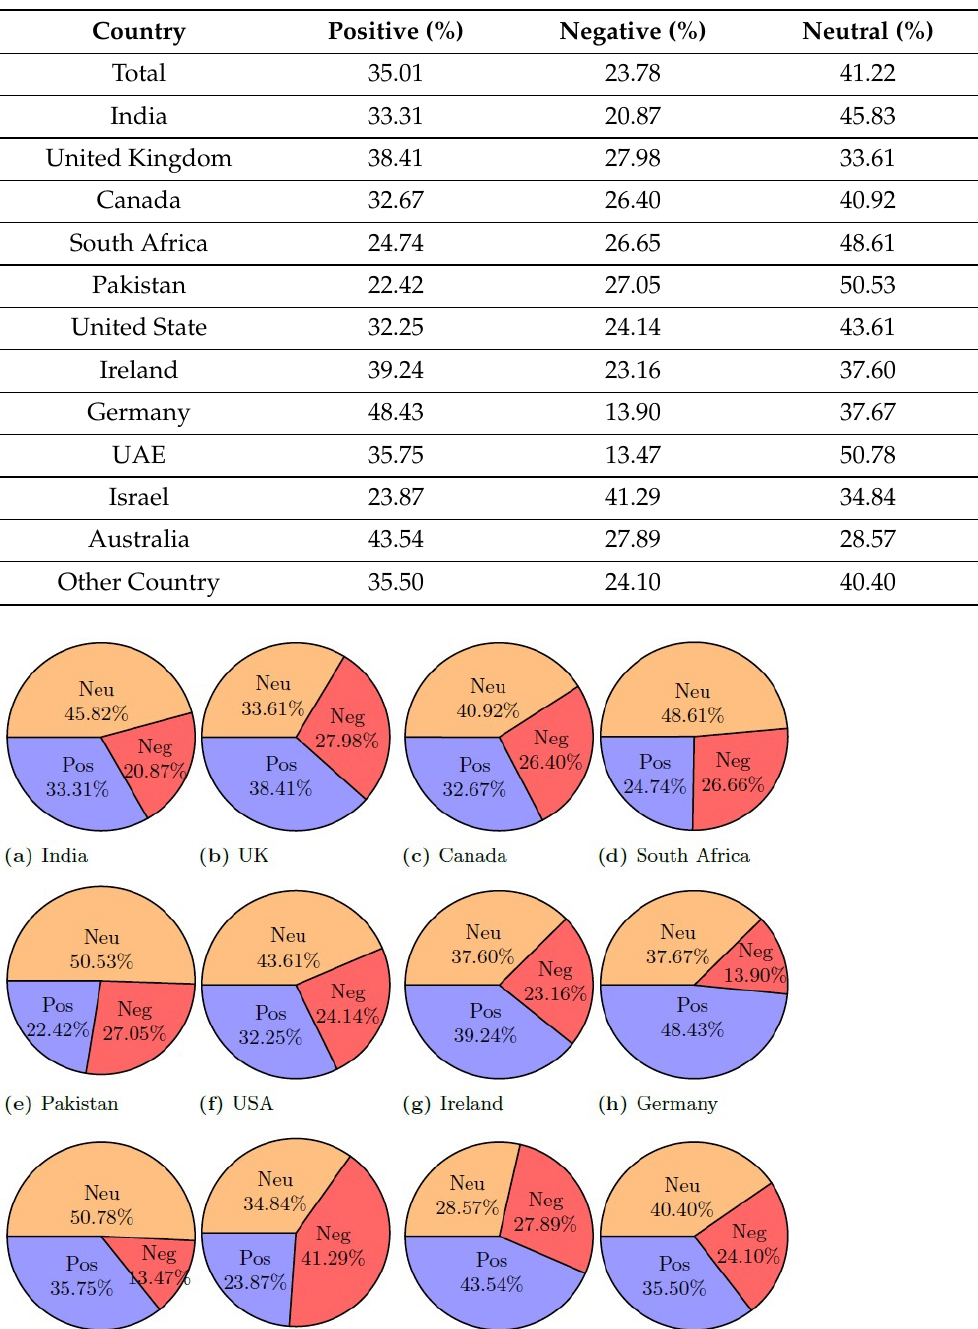
Table 13. AFFIN sentiment statistics for each country and worldwide.